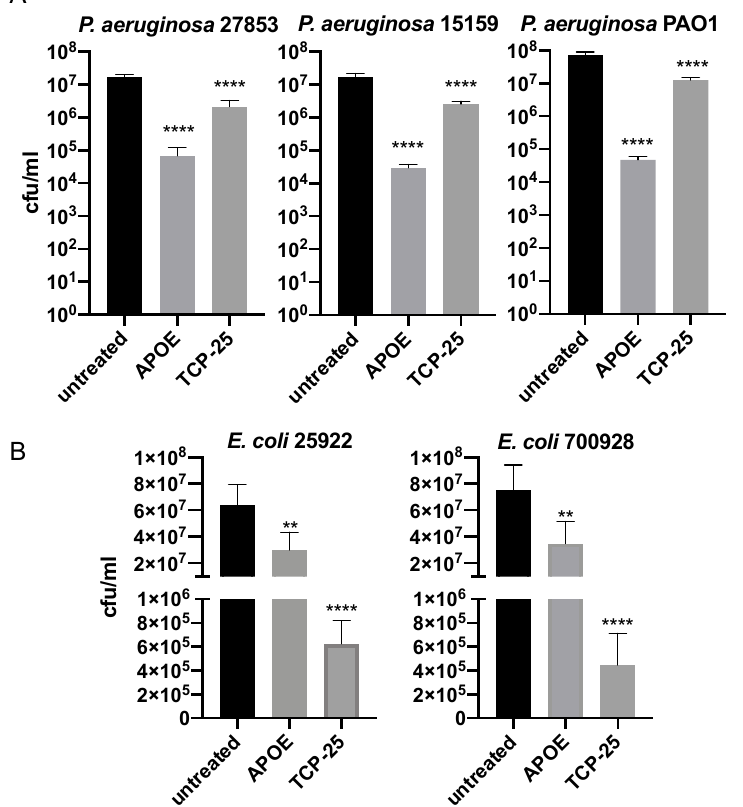
Figure 1. Antimicrobial activity of APOE in vitro. P. aeruginosa ( A ) and E. coli ( B ) were incubated with 2 µ M APOE for 2 h and then viable count assay was performed. Thrombin-derived peptide 2 µ M TCP-25 was used as a positive control, whereas the untreated bacteria were used as negative control. Data are presented as the mean ± SEM of four independent experiments ( n = 4). Statistical analysis was performed using a one-way ANOVA with Dunnett’s multiple comparison tests, ** = p ≤ 0.01 and **** = p ≤ 0.0001.